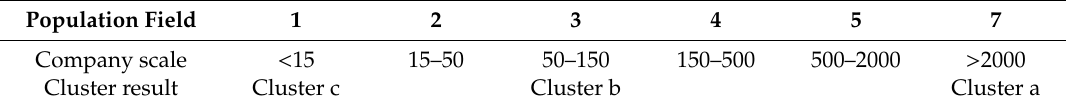
Figure 11. Location distribution of Internet and e-commerce companies from lagouwang. Table 4. The population field set for the kernel density estimation method.